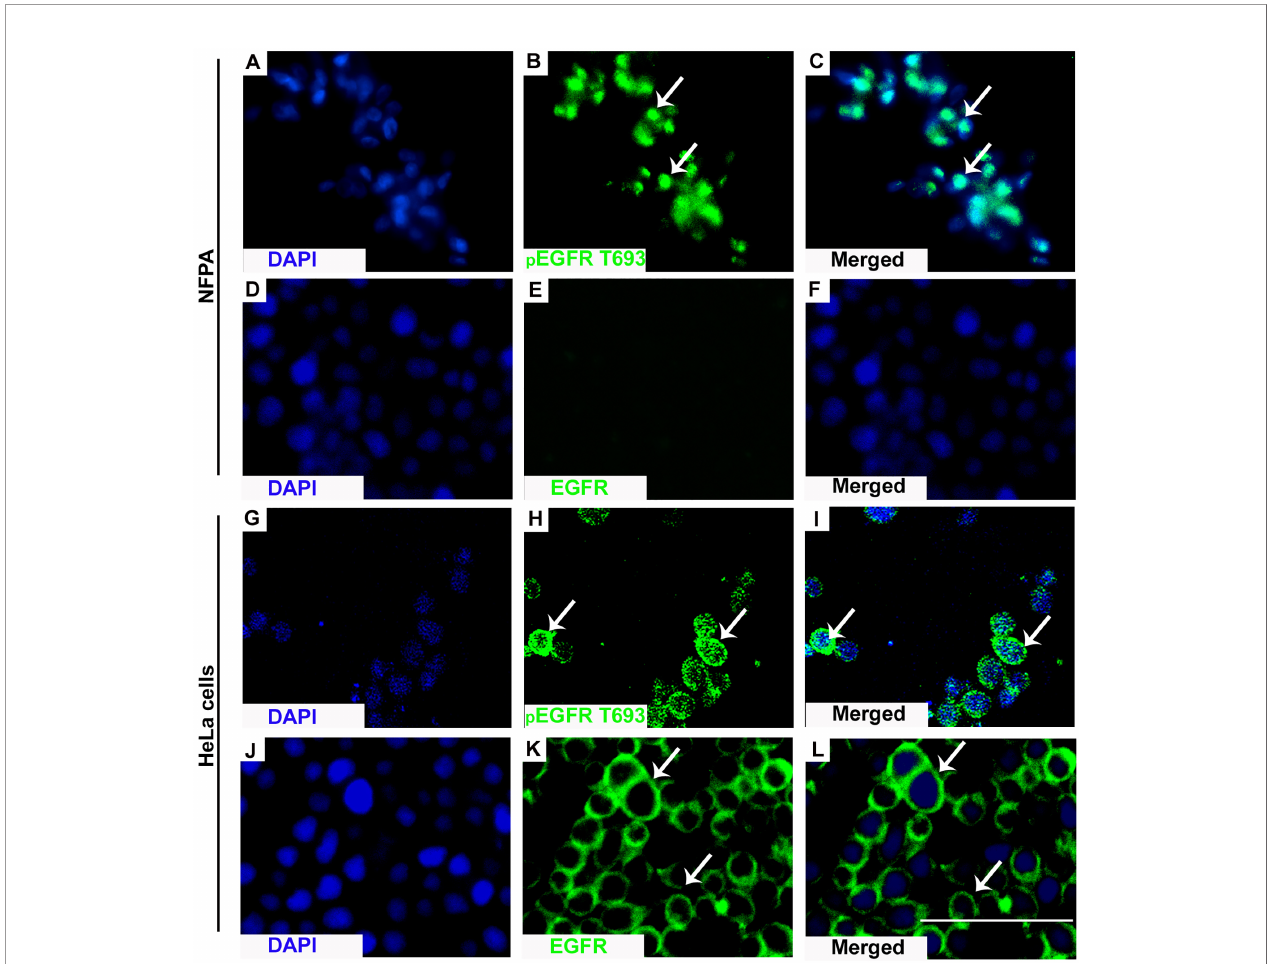
FIGURE 2 | Nuclear localization of pEGFR T693. IF showed nuclear localization of pEGFR T693 in NFPAs (A – C) and HeLa cells as the positive control (G – I) . In HeLa cells, EGFR showed membranous positivity (J – L) while no EGFR expression was observed in NFPAs (D – F) . EGFR and pEGFR T693 are shown by green while the nucleus is represented as counterstaining by DAPI (blue). Magni fi cation